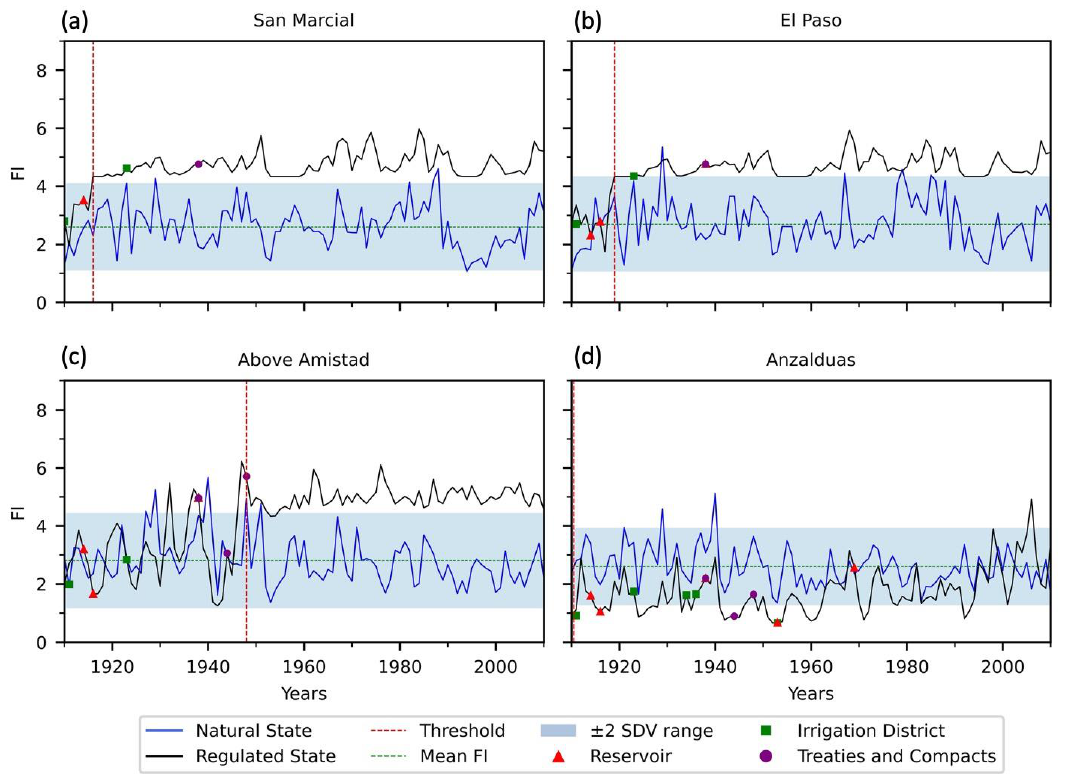
Figure 8. Analysis of regime shifts using Fisher Index (FI) in the mainstem of the Rio Grande– Bravo Basin including the control points of ( a ) San Marcial, ( b ) El Paso, ( c ) Above Amistad, and ( d ) Anzalduas. FI scores of the subfigures are shown for the natural (blue line) and regulated (black line) states, and the thresholds (dashed red line) indicate the year of a regime shift occurrence. The regulated state includes accumulated perturbations such as reservoirs, irrigation districts, and treaties and compacts. The ±2 standard deviation (SDV) range (blue area) including the mean FI value (dashed green) indicate the baseline limits to detect regime shifts for the regulated system. Table 2 . Sustainable regime null hypothesis evaluation defined by the dynamics of the natural flow regime.